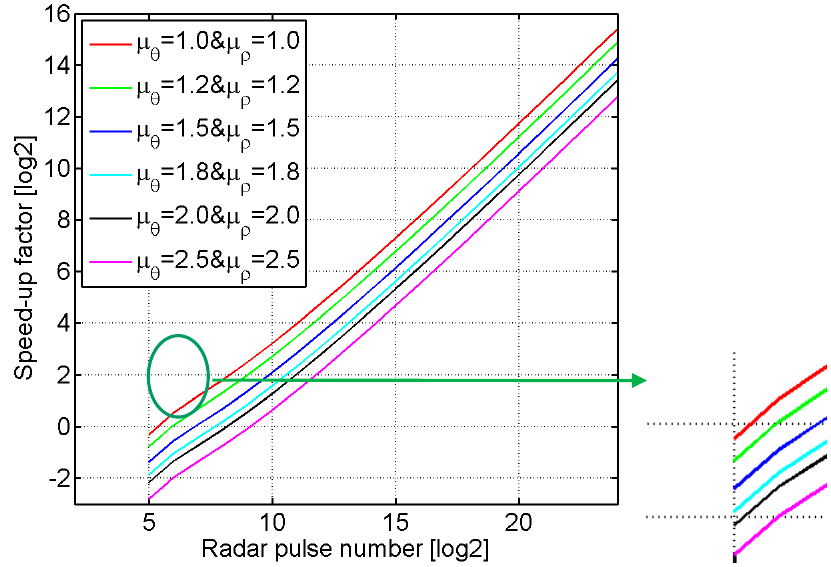
Figure 6. The logarithm (base 2) of the speed-up factor of the proposed ETDA for the different values of the factors μ θ and μ ρ .